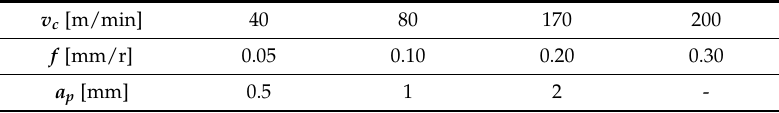
Table 3. Cutting parameters values used in the turning tests.